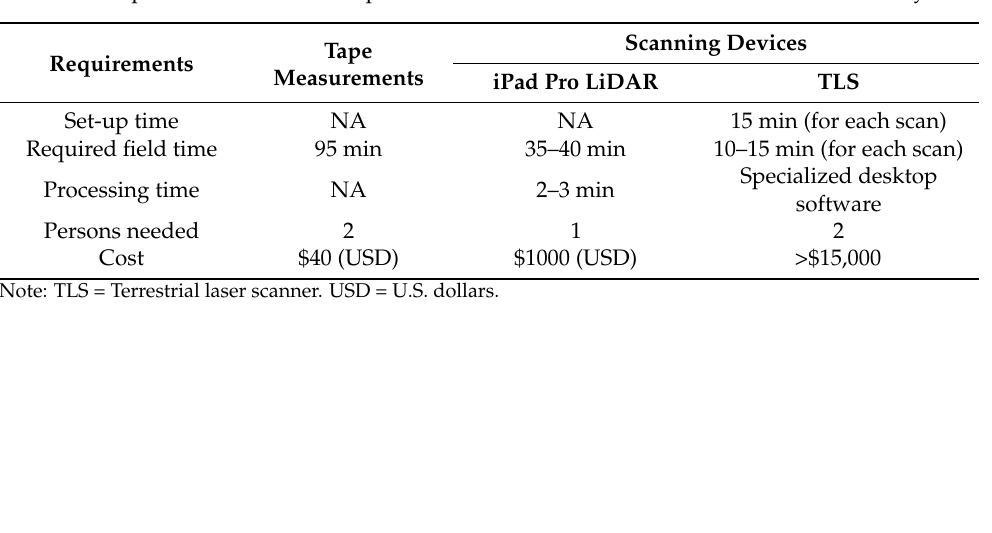
Table 2. Comparison of traditional tape measurements with the iPad Pro LiDAR and a TLS